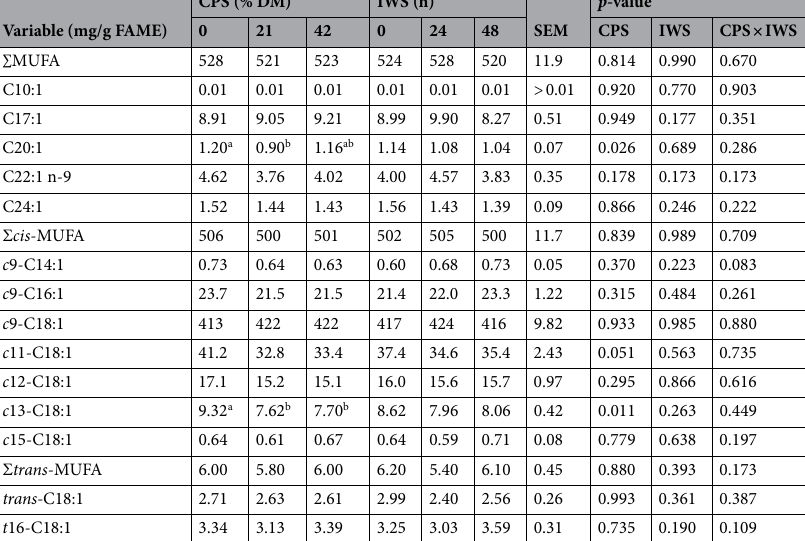
Table 7. Monounsaturated fatty acids (MUFA) from Longissimus lumborum muscle of goats fed with cactus pear silage (CPS) and submitted to intermittent water supply (IWS). a,b Means within rows with different letter superscripts differ by Tukey test ( p <